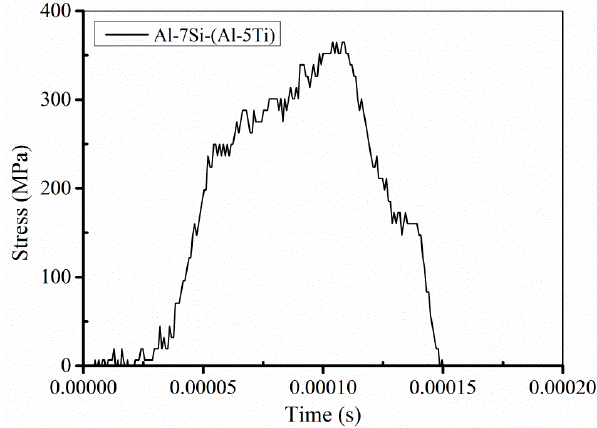
Figure 15. The stress-time curve at 5 m/s of the H 0 specimen.